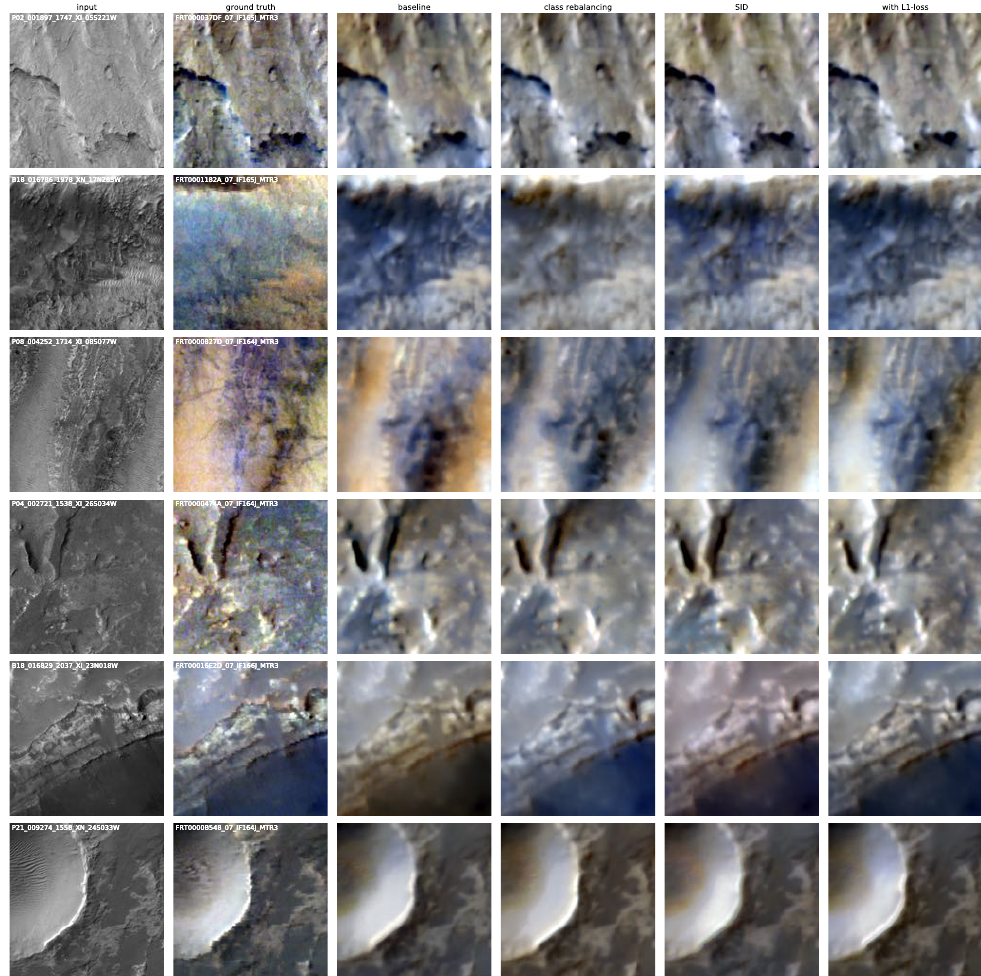
Figure 17. Appearance comparison of six EVC test patches across different modifications to the classification